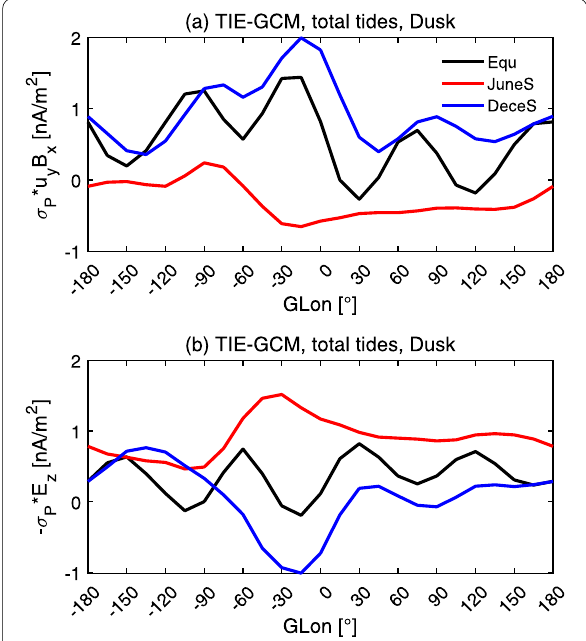
Fig. 7 Longitudinal distributions of the dynamo and polarization currents at dusk sector in equinoxes, JS, and DS. Black, red, and blue curves denote the equinox, JS, and DS. Positive values represent outward